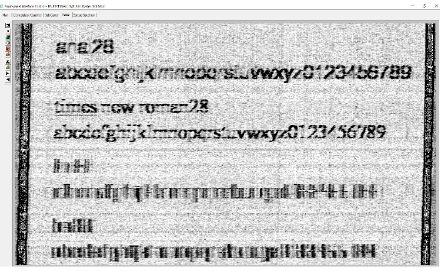
Figure 16. Image recovered with Font 28: Arial, Times New Roman, secure asymmetrical and secure symmetrical.